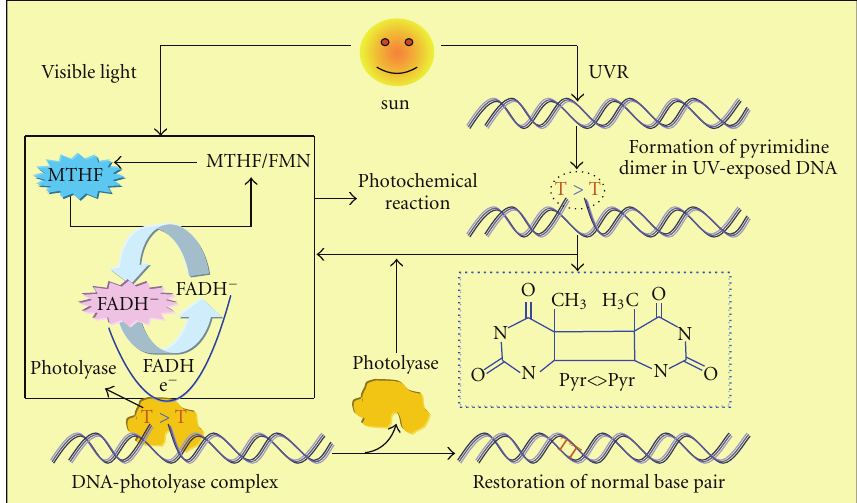
Figure 9: Photoreactivation: incidence of ultraviolet radiation (UVR) results in pyrimidine lesion (thymine dimer), which is recognized by a photoreactivating enzyme “photolyase”. The light energy ( > 380nm) is trapped by the antenna molecules of photolyase (such as MTHF/8- HDF/FMN) and transfers them to catalytic cofactor FADH − which becomes excited and transfers energy to the pyrimidine dimer in the form of e − , splitting the CPD into two monomeric unit, and then electron is transferred back to the flavin